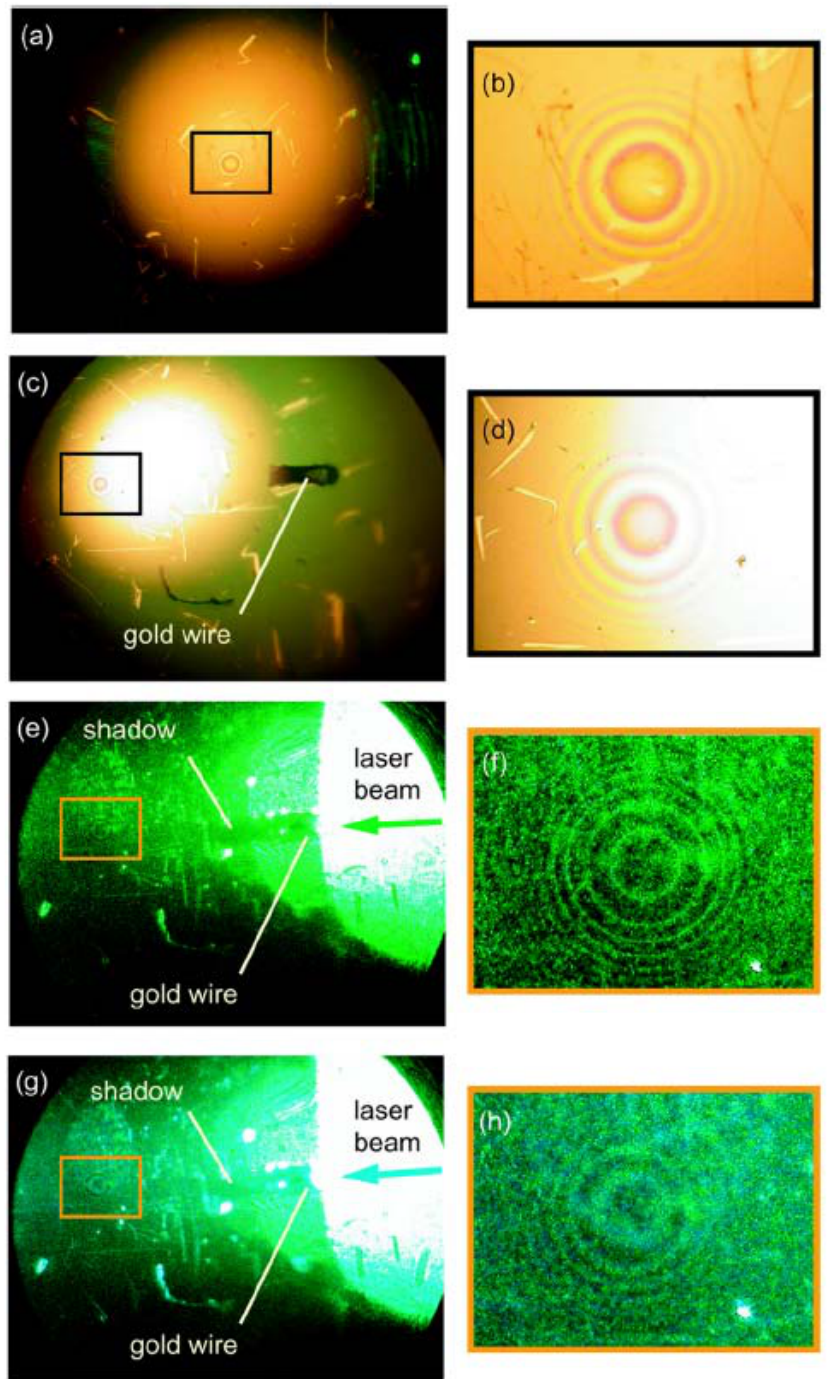
Figure 3. ( a ) Microscope image of the waveguide without a particle (white light coming from the top). ( b ) Magnified Newton rings taken from the frame in (a). ( c ) Image of the waveguide with a gold particle (white light coming from the top). ( d ) Magnified Newton rings taken from the frame in (c). A long shadow cast by the gold particle upon coupling (via side illumination) 515-nm ( e ) and 488-nm ( g ) laser light into the waveguide. Magnified images of the rings for 515-nm ( f ) and 488-nm ( h ) light taken from frames in (e) and